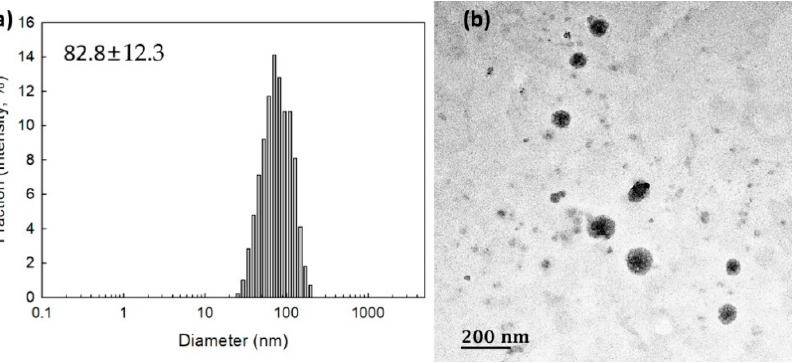
Figure 3. ( a ) Typical particle size distribution and ( b ) TEM photo of bCDsuMema nanoparticles. Table 2. Changes of particle size distribution caused by the addition of H 2 O 2 (derived from Figure 4a).